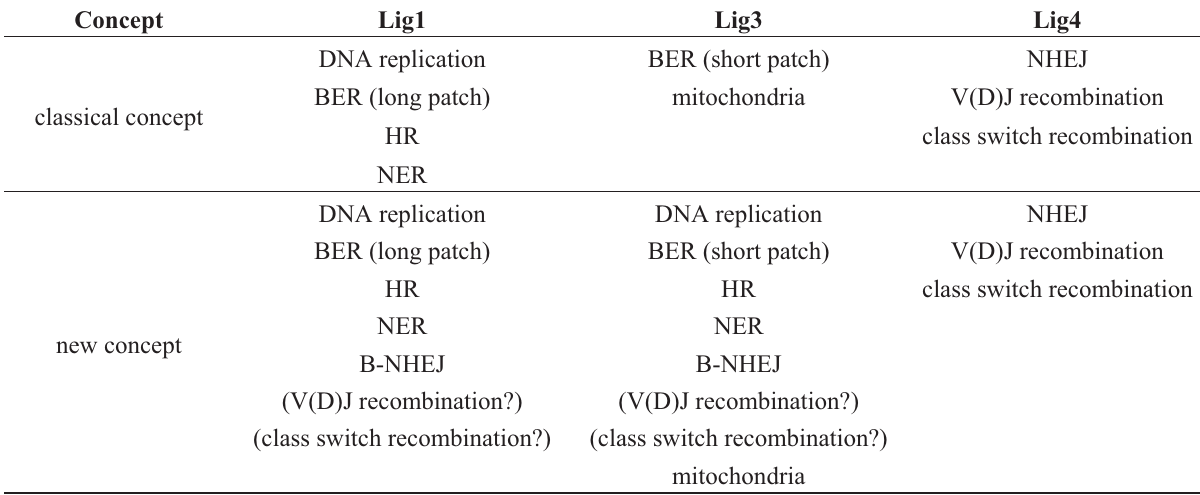
Table 1. Roles of DNA